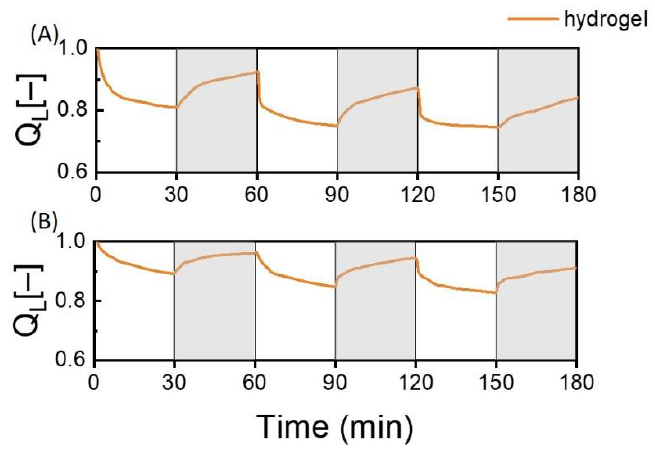
Figure 5. Length normalized swelling degrees (Q L ; cf 4.4.3) of PVA10/(PVA-MA)-g-PNIPAAm on cycling between 25 °C and 50 °C ( A ) or 40 °C ( B ) in deionized water. The hydrogel of PVA10/(PVA-MA)-g-PNIPAAm does not form obviously in the